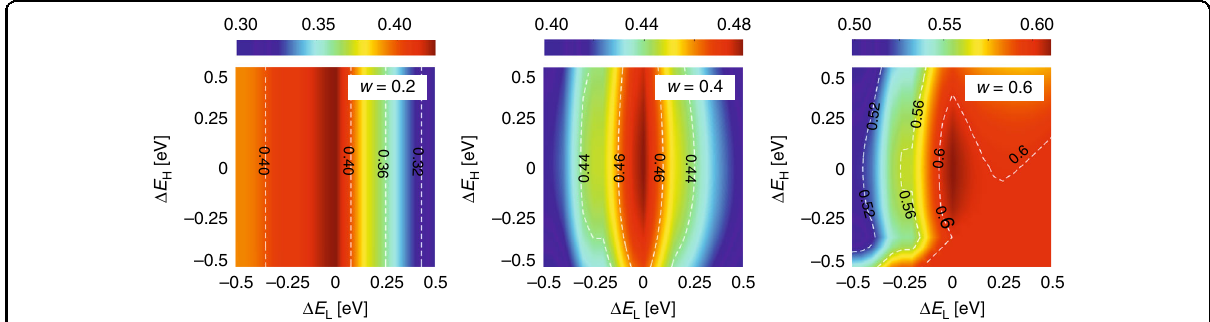
Fig. 12 In fl uence of deviations of E L and E H from their optimal values on the SSPVT total effective ef fi ciency limit η tot ( C = 100, PV material: